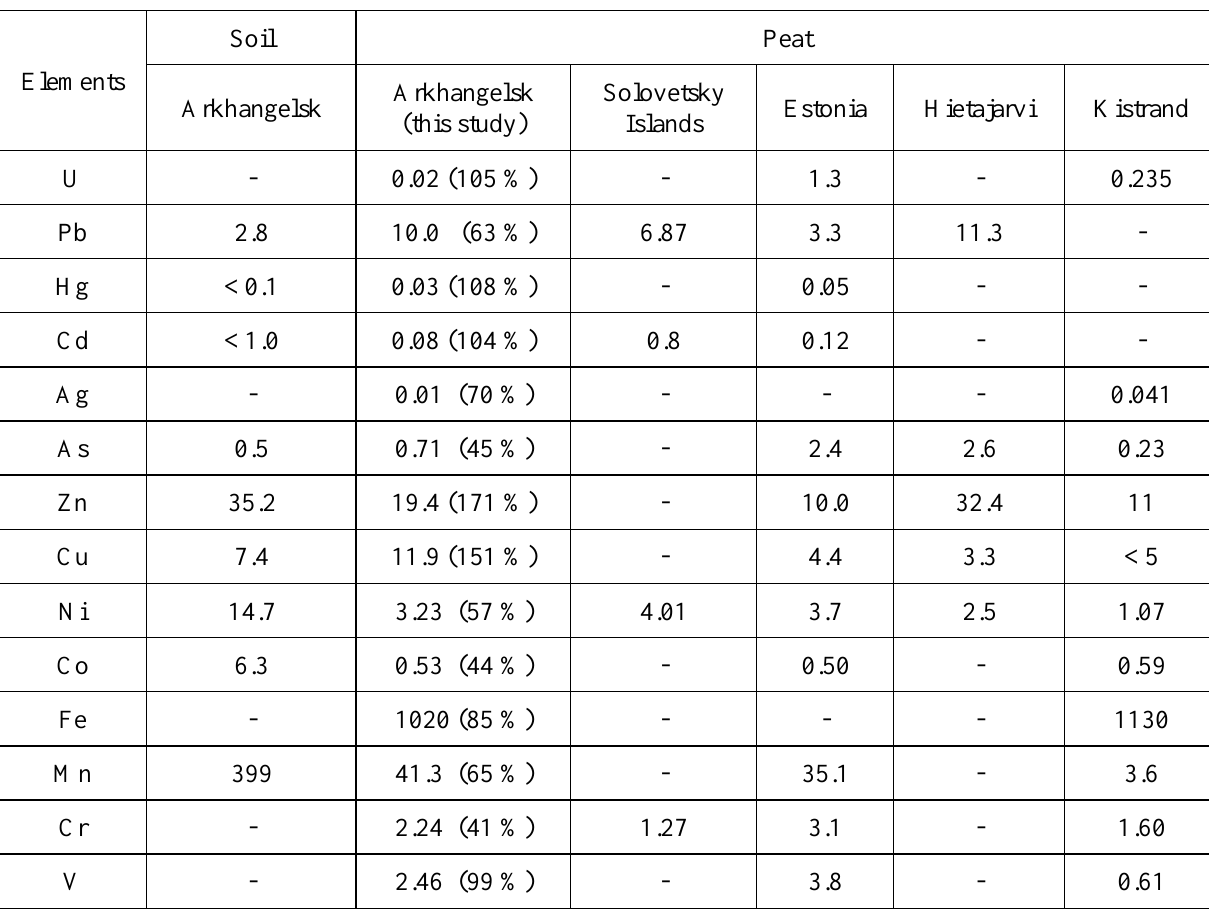
Table A2. Median concentrations of all elements (mg kg -1 ) and CV (%) values determined in this study (see Table A1) in comparison with average concentrations of elements reported in the literature for soils in Arkhangelsk region (Popova 2014). and for peat in the Russian Solovetsky Islands (Kozioł et al . 2020) as well as in other European countries: Estonia (Orru & Orru 2006); Hietajarvi, Finland (Ukonmaanaho et al . 2004); and Kistrand, Norway (Frontasyeva & Steinnes